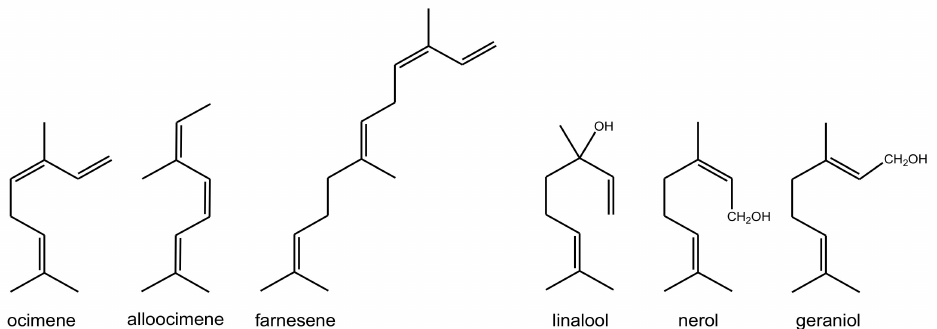
Figure 3. Structure of noncyclic terpenes and terpene alcohols, polymerized to elastomeric